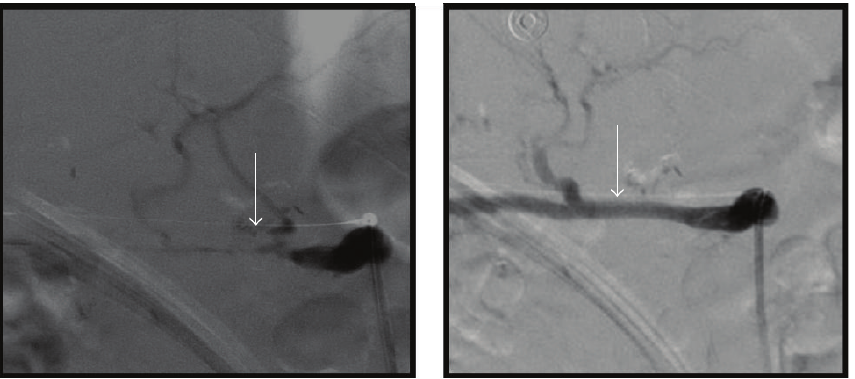
Figure 4: Angiogram with hepatic artery stent placement on day 21 showed critical stenosis of the anastomotic segment of replaced hepatic artery. Subsequent balloon dilatation and stenting with 2–5 mm stents was completed.